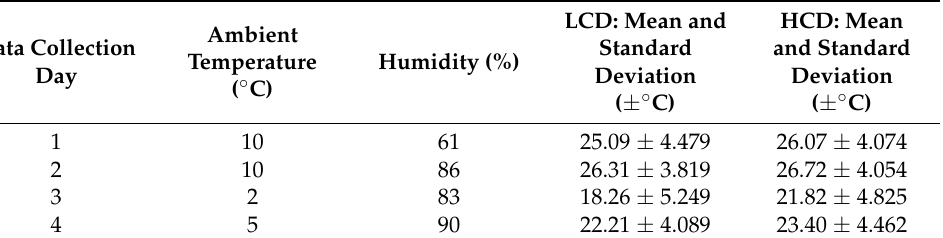
Table 3. The ambient temperature, relative humidity, mean foot temperature, and standard deviation of temperature of sound hind feet on each of the data collection days for both infrared thermography devices used in this study.